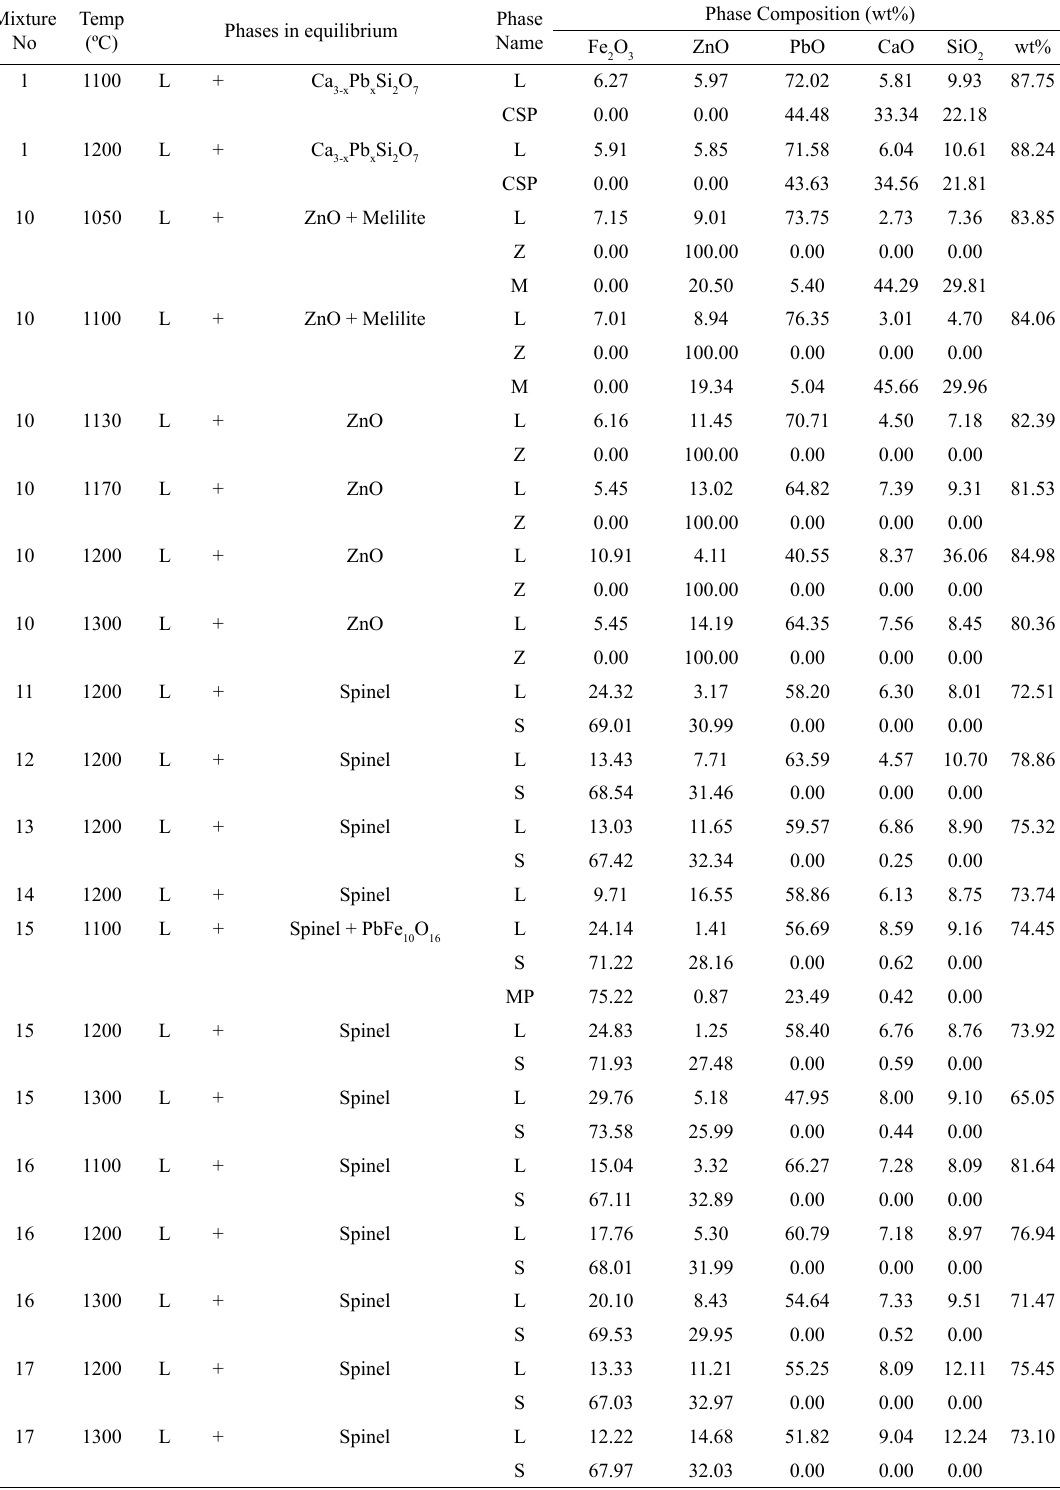
weight ratio of 1.1 and PbO/(CaO+SiO 2